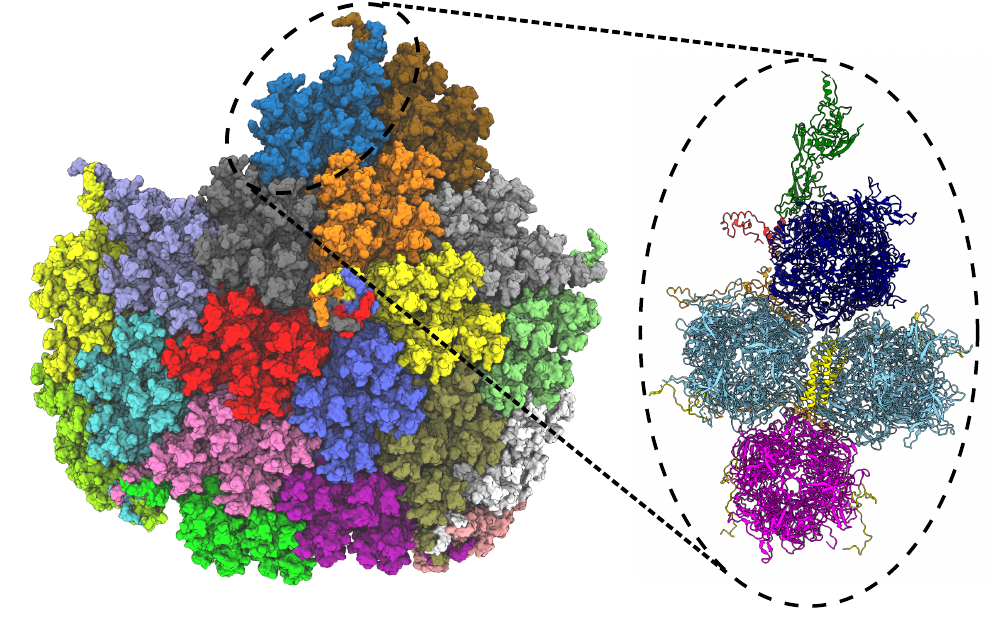
Figure 5. Facet of ChAdOx1 adapted from chimpanzee adenovirus Y25 (ChAd-Y25), which is the basis for the AstraZenica COVID-19 vaccine (AZD1222/Vaxzevria). The full capsid (T = 25) point symmetry of the viral vector consists of 60 copies of the asymmetric unit, which once optimized was published as PDB 7RD1 [34]. The full facet (left) comprises 19 asymmetric units, each represented by a surface representation with a unique color. The full facet illustration is prepared in VMD 1.9.4a55 [28]. The dashed circle (black) represents an asymmetric unit, which is expanded in the left panel to highlight the different proteins in the asymmetric unit of ChAdOx1 virus capsid. The unit contains a penton monomer (green), a trimeric peripentonal hexon (blue), two copies of 2 (cid:48) hexons (sky blue), a copy of 3 (cid:48) hexon (magenta), a tetrameric helical bundle protein IX (yellow), protein IIIa (red) and pre-hexon-linking protein VIII (orange). The illustration is prepared using ChimeraX